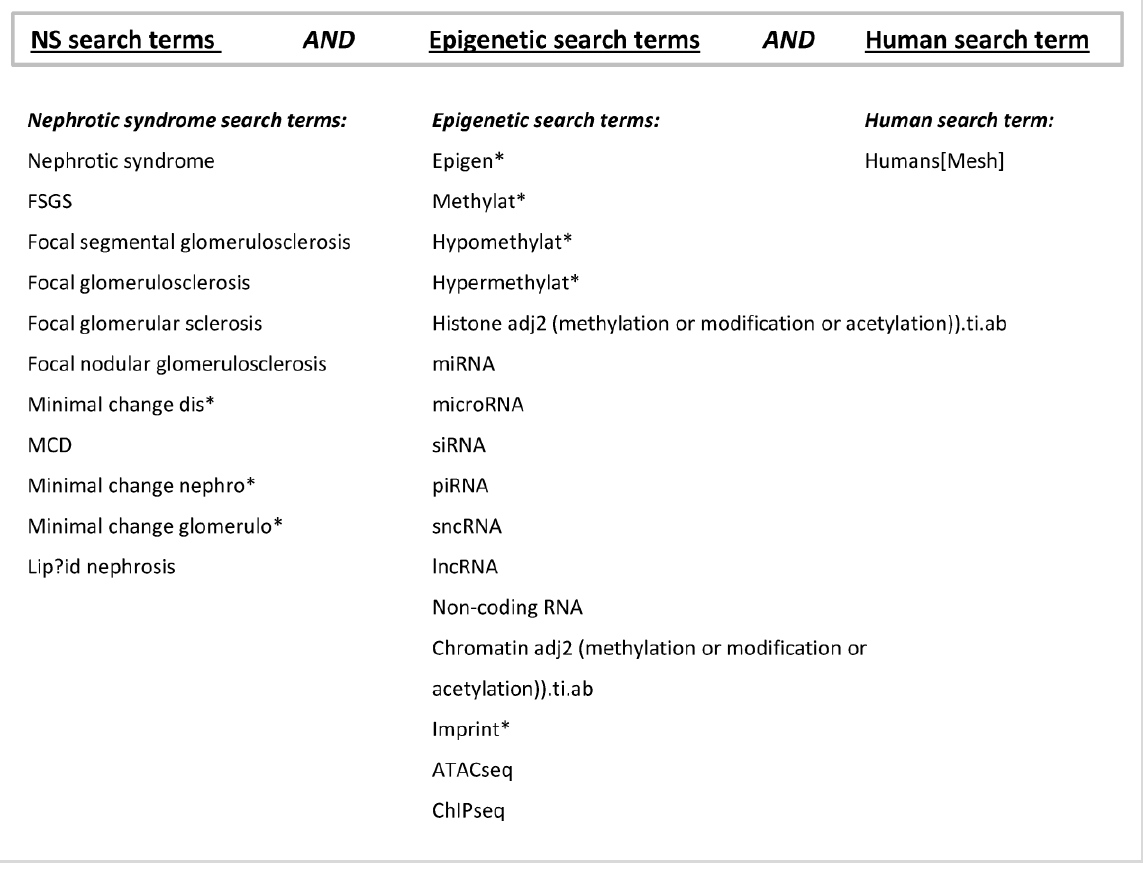
Figure 1. Systematic review search terms. Search term symbols: * trunation (broadens the search to include any ending to the word); wildcard character (in the search the character can be substituted for zero or one character of a word).